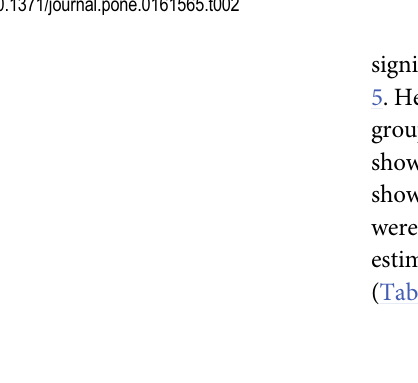
significantly different (Levene statstic = 7.76, p = 0.01), as illustrated in the boxplots in Fig 1,15 5. Hence the non-parametric independent samples median test was used to investigate between group differences, for which no significant difference in the medians was found (p = 1.0). Fig 5 shows that the abnormal group had more extreme tails than the normal group for D 2 . Fig 6 shows the children ’ s VEPs, including those that had the extremely high or low D 2 . CI and CII were not consistently repeatable. Therefore only the CIII component latencies could be reliably estimated for all children, as CIII amplitude depended on the CII component being repeatable (Table 3).